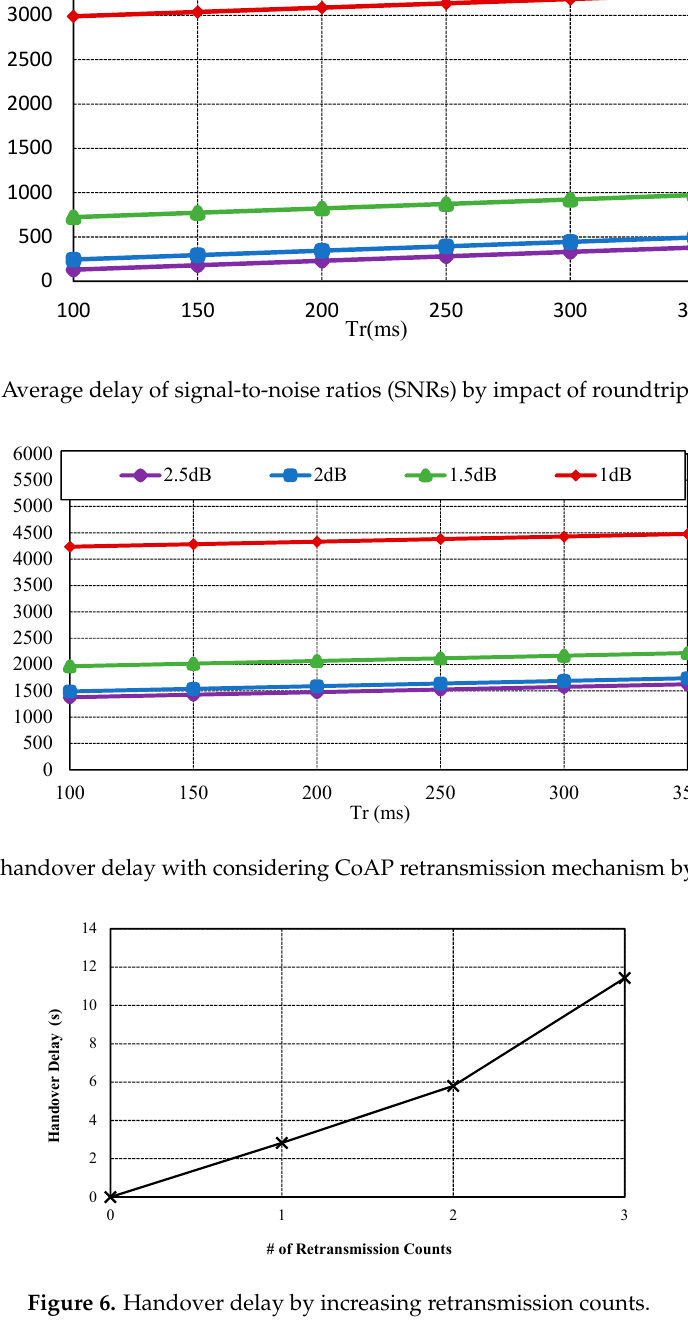
Figure 6. Handover delay by increasing retransmission counts.